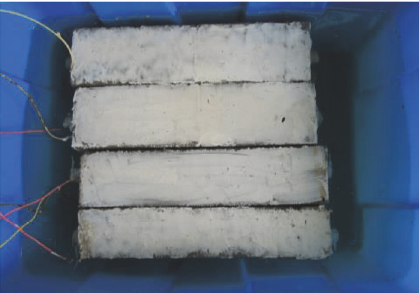
Figure 3: Electrochemical analysis